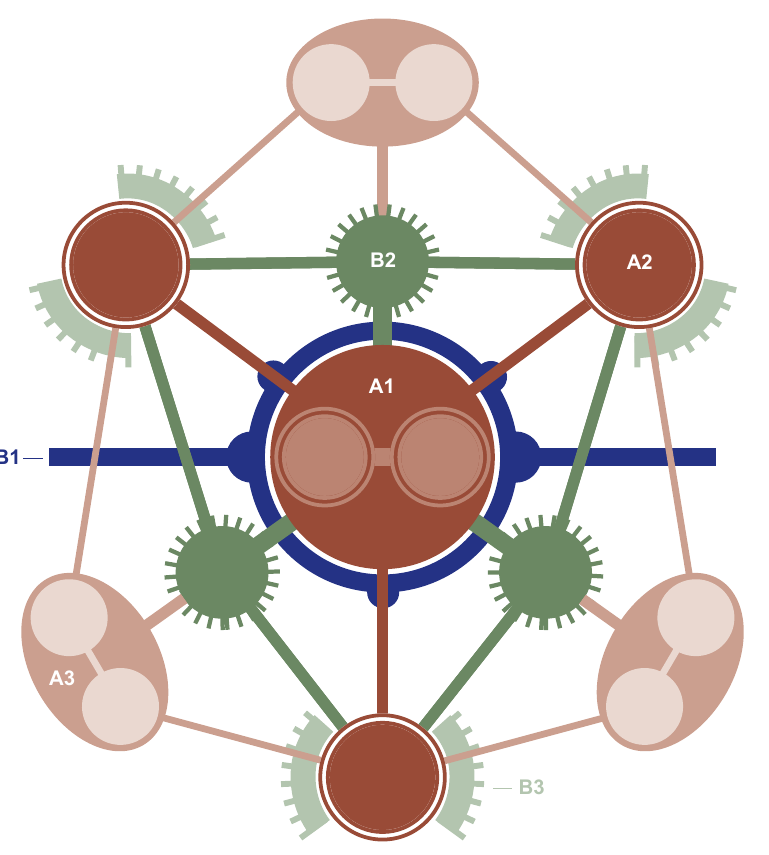
Fig. 2. Theoretical model of city‘s cultural framework (place level)